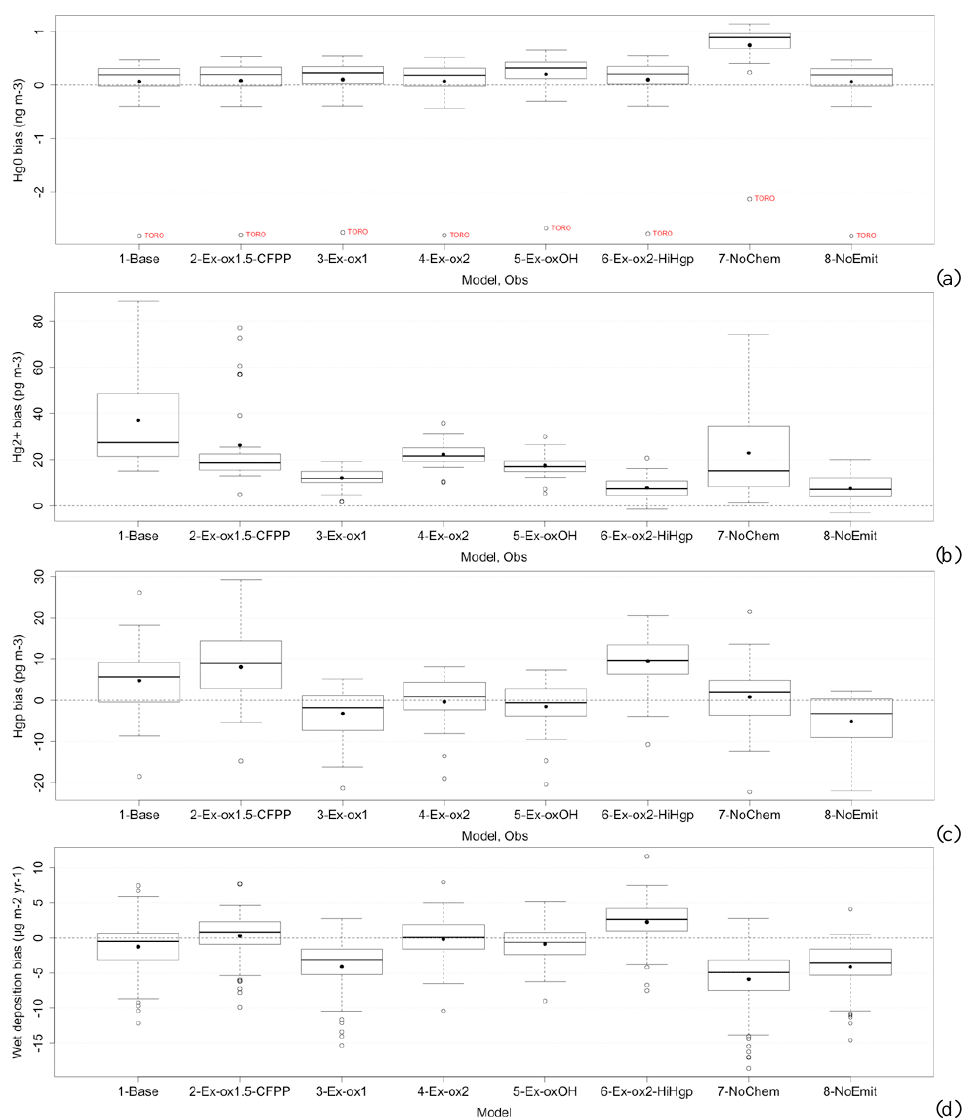
Fig. 4. Spread of yearly bias for different model runs. For a detailed model run description, see Table 2. (a) Hg 0 , (b) Hg 2 + , (c) Hg p , (d) wet